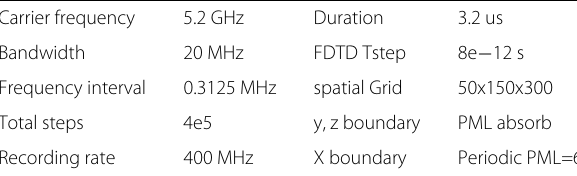
versus data rate” in 802.11a, we obtain the allowed rate under different RCE and make an evaluation of the trans- mission. Finally, we test out the target recognition by using the preamble